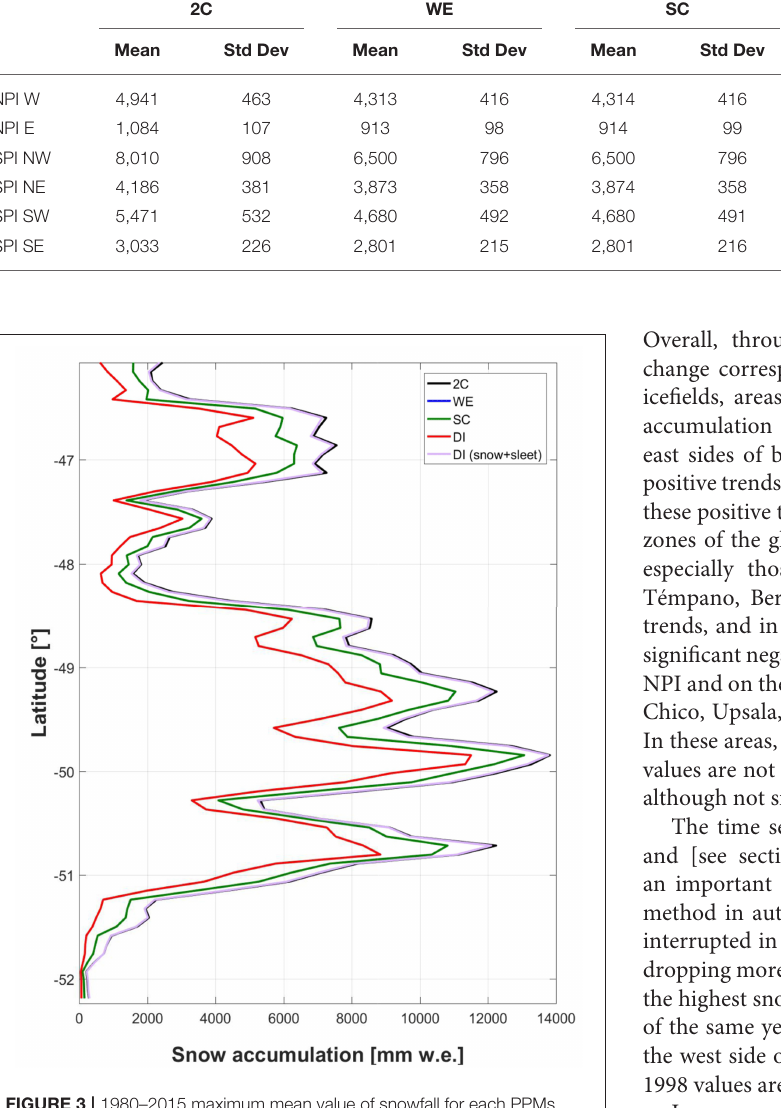
FIGURE 3 | 1980–2015 maximum mean value of snowfall for each